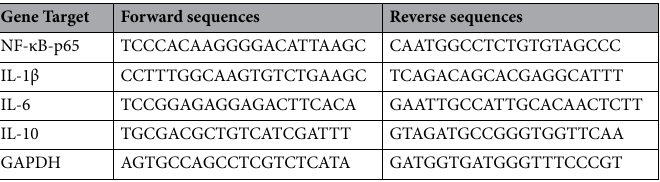
Table 2. Gene target primer